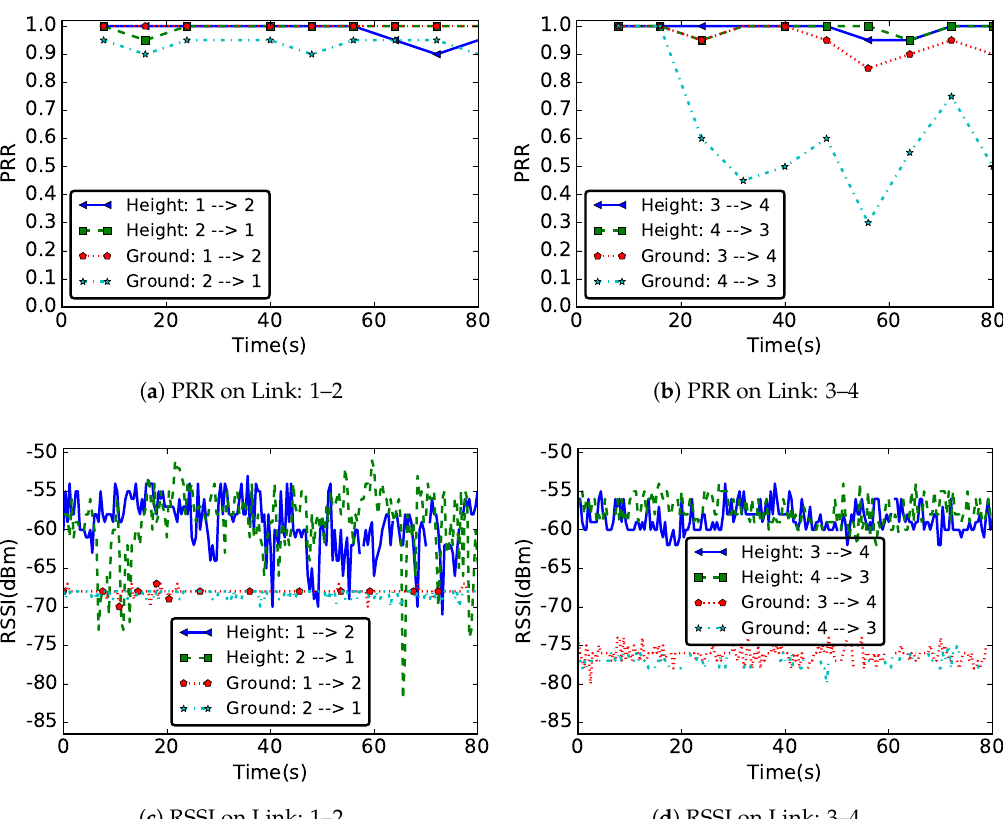
Figure 5. Variation of PRR and RSSI values over time on wireless links 1–2 and 3–4, with the same distance of 3 m, in two different deployments: one with sensors deployed at ground level (labeled “Ground”) and another with sensors deployed on a support of height 57 cm (labeled